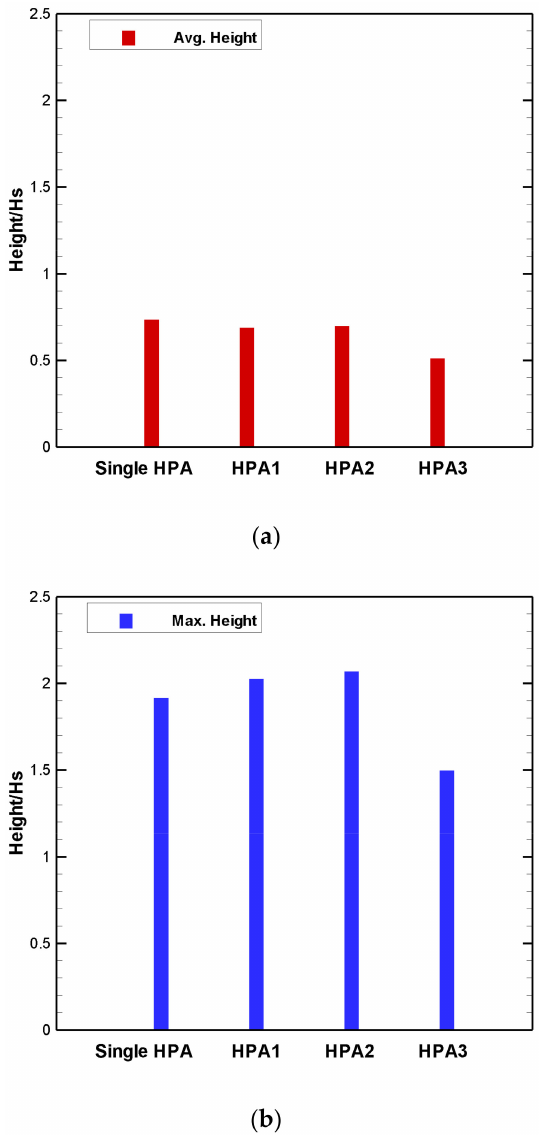
Figure 20. Motion responses of HPAs in operational condition (Hs = 3.0 m, Tp = 6.67 s, Vc = 0.14 m/s except single HPA, wave heading angle = 0 ◦ ); ( a ) Average height; ( b ) Maximum